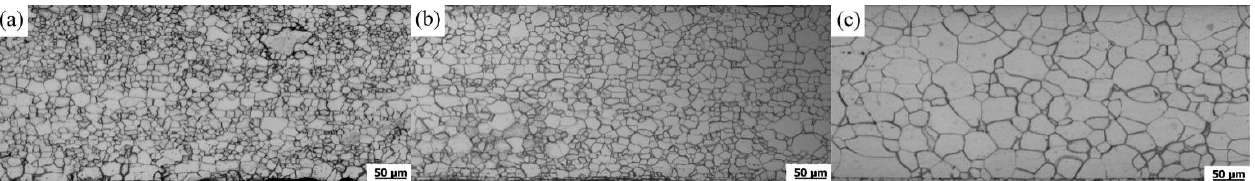
Figure 1. Microstructure of decarbonized annealing samples along the thickness direction: ( a ) 850 ◦ C × 3 min; ( b ) 850 ◦ C × 5 min; ( c ) 850 ◦ C × 7